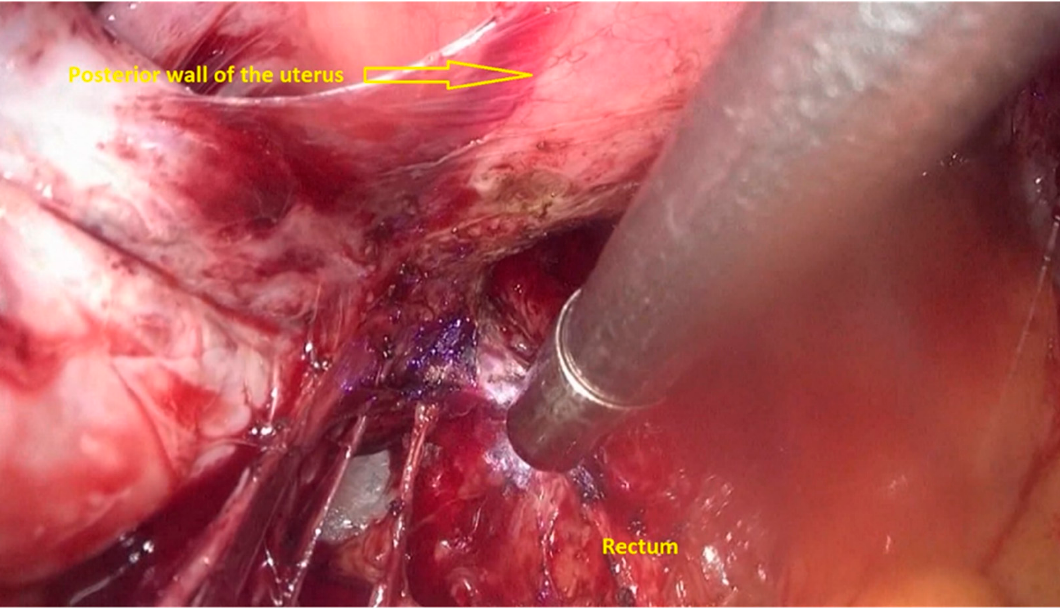
Figure 4 . Dissection and removal of the fat tissue on the left lateral rectal wall . Figure 4. Dissection and removal of the fat tissue on the left lateral rectal